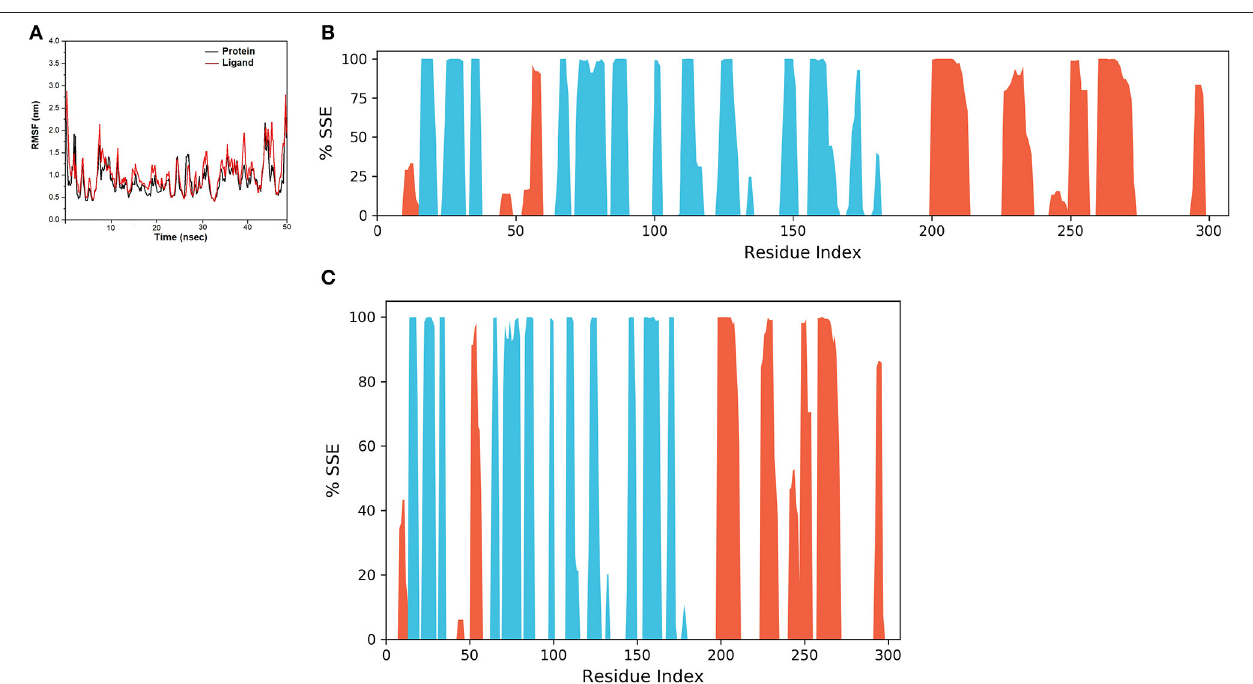
FIGURE 9 | Results of MD of DMO-SARS-CoV-2 M pro complex. (A) RMSF of the DMO-M pro complex. RMSF of protein and ligand were < 2 Å throughout the simulation time. (B) SSE of the apo form of M pro . (C) SSE of the DMO-M pro complex. M pro was conformationally stable as there was no considerable change in %